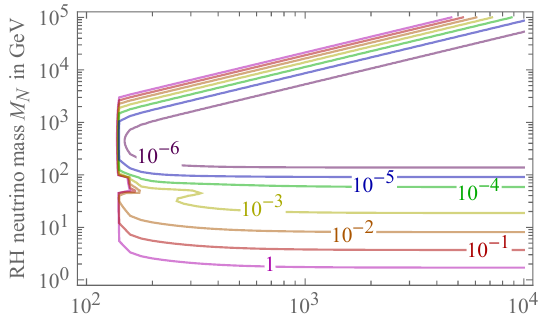
Figure 4 . Leptonic CP asymmetry (cid:15) CP needed to obtain successful leptogenesis, assuming right- handed neutrinos in thermal equilibrium at the temperature T RH . For M N & M h ( M N < (cid:24) M h ) the asymmetry comes from decays of right-handed neutrinos (of the Higgs), and the needed (cid:15) CP is obtained from right-handed neutrinos degenerate at the (cid:1) M N =M N (cid:25) 10 (cid:0) 7 level (at the 10 (cid:0) 5 level). We (cid:12)xed the Yukawa couplings to j Y N j 2 v 2 =M N = 10 (cid:0) 11